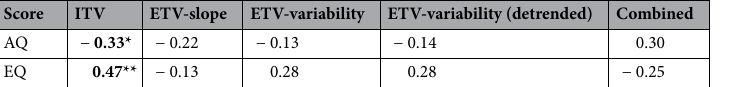
Table 2. Correlation of scores and metrics. The Pearson correlation coefficients between variability-related metrics and the AQ & EQ questionnaire scores. The correlation between questionnaire scores and all variables combined were calculated using the hyperplane distance of the SVM (see “Methods” section for explanation). Statistically significant correlations are shown in bold. * p < 0.05 ; ** p < 0.01